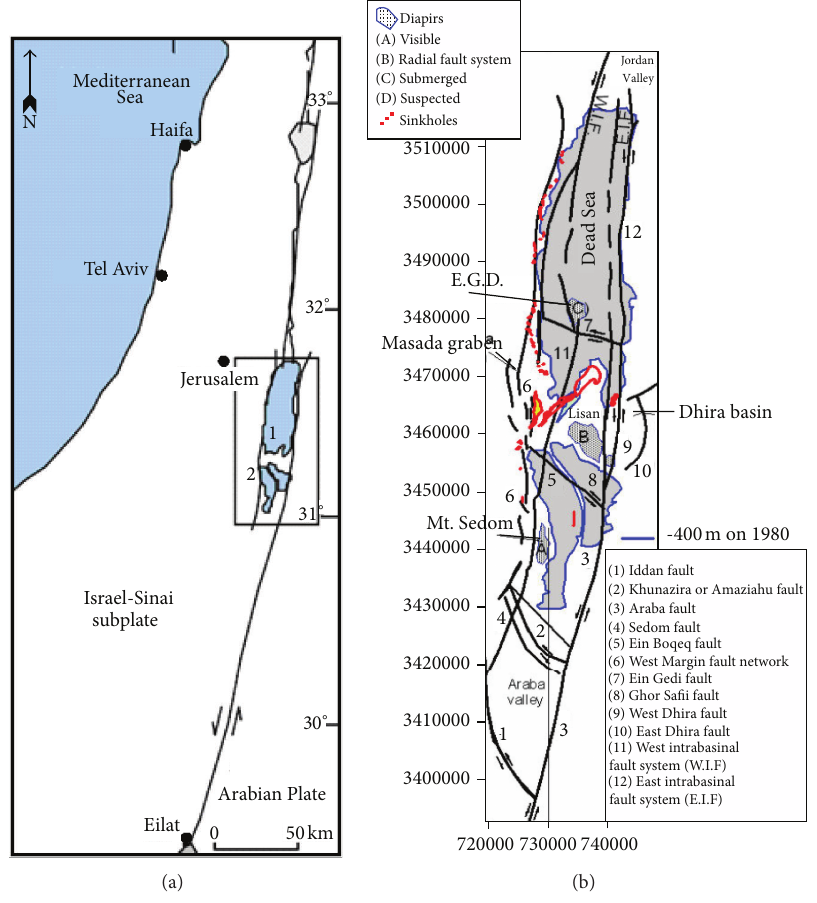
Figure 4: Dead Sea tectonic setting: (a) Dead Sea transform; (b) faults through the DS area [4].